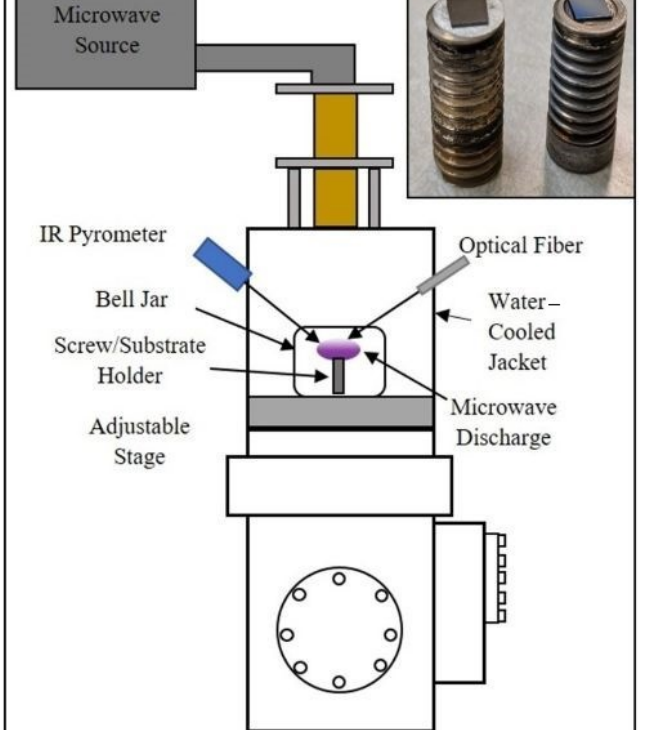
Figure 2. Schematic of the 6 kW microwave plasma chemical vapor deposition (MPCVD) chamber used in our experiments. The inset shows the two types of substrate holders utilized in the CVD growth of B-C microstructures.